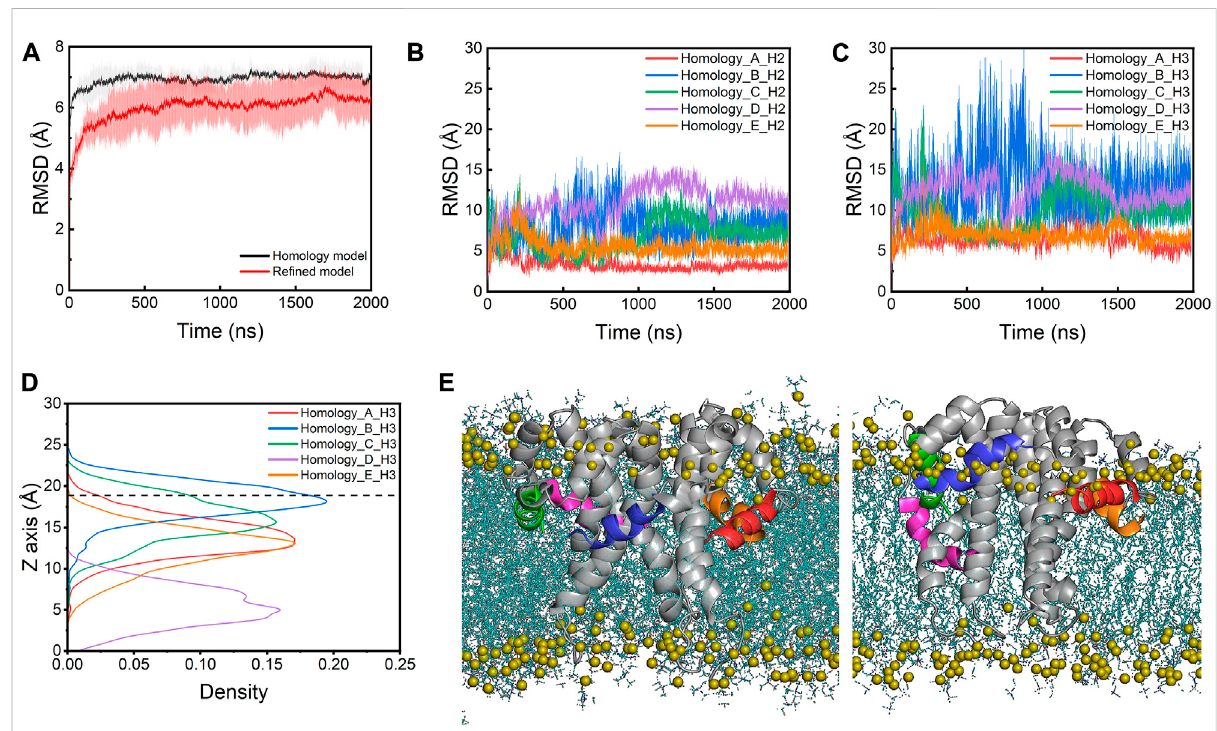
FIGURE 2 (A) RMSDsofthehomologymodelandthere fi nedmodel.Thelinesarethemeanvaluesaveragedfromthethreeparallelsimulations.Theshade areaisthestandarddeviation.RMSDsof (B) theH2s and (C) theH3softhehomologymodel. (D) Thedensity pro fi leofthecentersofmass(COMs) of H3s along the membrane normal in the simulations of the homology model. The average position of the phosphorus atoms on the upper lea fl et is shown as a dashed line for reference. (E) The initial (left) and last frame (right) of the homology model in a POPC bilayer from the AA-MD simulations. H3 helices of chain A-E are colored with red, blue, green, magenta and orange, respectively. Lipids are shown as blue lines and the phosphorus atoms are shown as olive